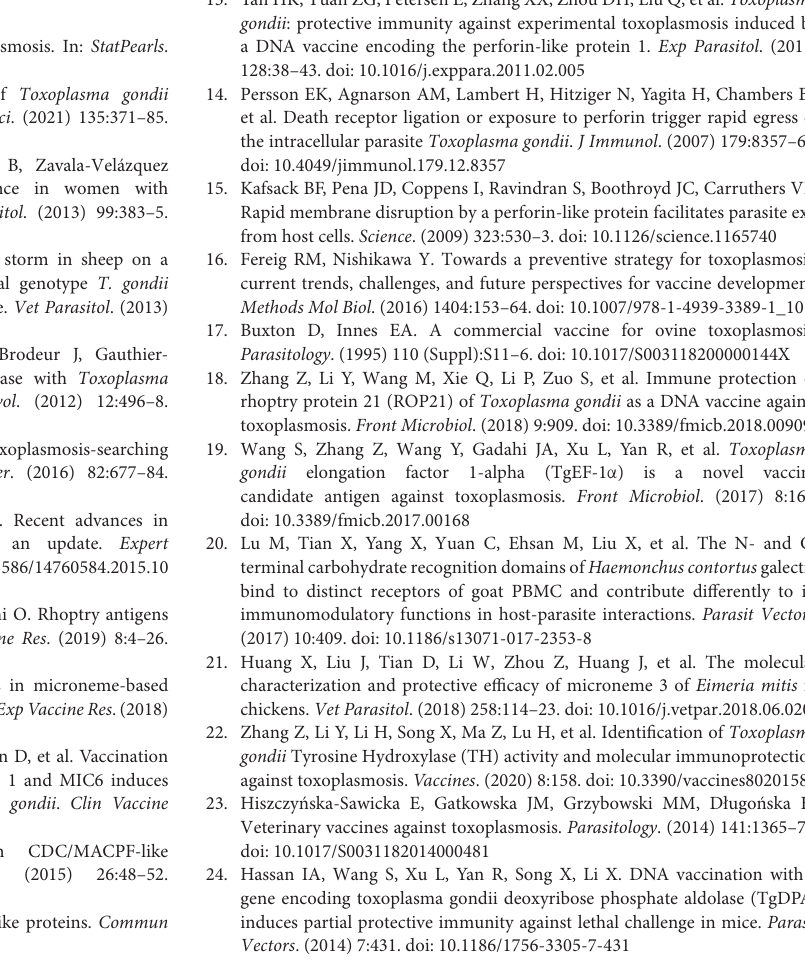
Supplementary Figure S1 | Immunoblotting analysis of specific antibody anti-rTgPLP2 (A) . Diaminobenzidine (DAB) substrate was used for band visualization. M showed standard protein ladder; Line 1: Normal mice sera were utilized as negative controls; Line 2: Anti-rTgPLP2 rat serum was used as primary antibody and a clear band about 39.7 kDa was observed. ELISA analysis of serum anti-rTgPLP2 antibody titers (B) . Normal mice sera were utilized as negative controls. The cut-off values (0.03) are shown with a dotted line. Supplementary Figure S2 | Original picture of Figure 1C . Supplementary Figure S3 | Original picture of Supplementary Figure S1 . Supplementary Figure S4 | Original picture of Figure 3A Line 1. Supplementary Figure S5 | Original picture of Figure 3A Line 2. Supplementary Figure S6 | Original picture of Figure 3B . Supplementary Figure S7 | Original picture of Figure 1B . Supplementary Figure S8 | Original picture of Figure 1A